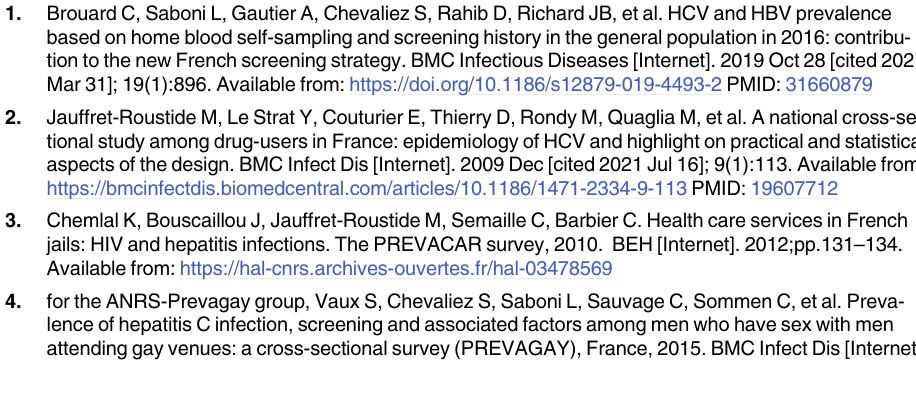
S2 Fig. Per-patient EVPI according to varying willingness-to-pay thresholds. S1 Table. Population EVPI across varying willingness to pay